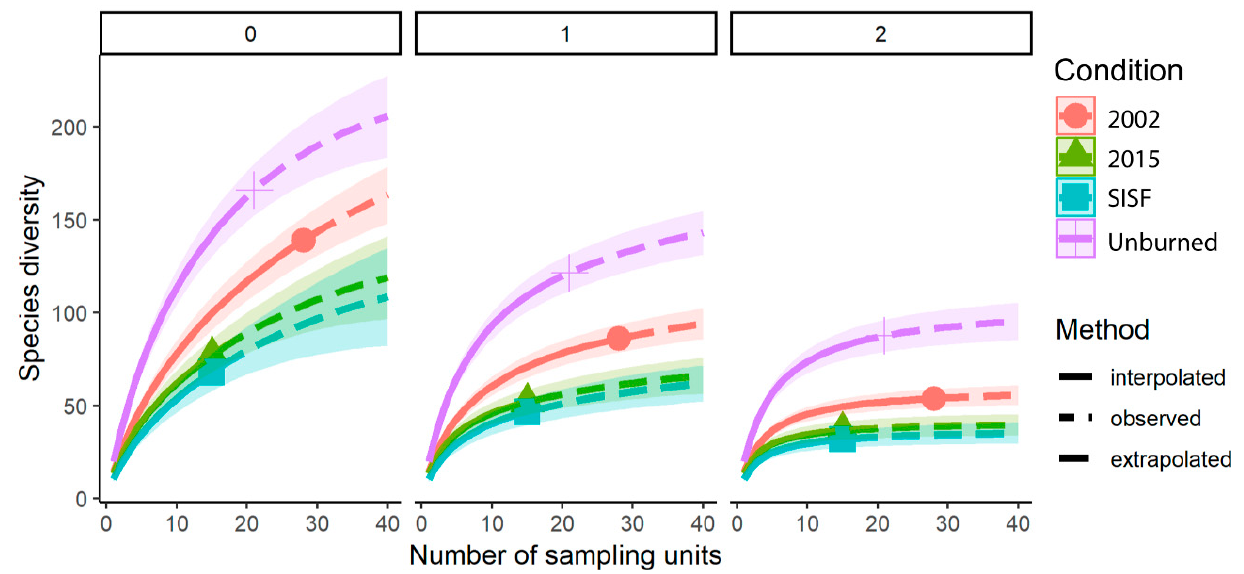
Figure 2. Sample-based rarefaction (solid lines) and extrapolation (dotted lines) of saproxylic beetles collected in unburned areas (plus); short-interval, severe areas (square); 2015-burned areas (triangle); 2002-burned areas (dots), with 95% unconditional confidence intervals (transparent shading). Species diversity correspond to q = 0, species richness; q = 1, exponential of Shannon’s entropy index; q = 2, inverse of Simpson’s index. Solid symbols represent the total number of samples recovered in field work. (Table 2: PERMANOVA, pseudo F (3,21) = 4.19, p -value < 0.01), and NMDS